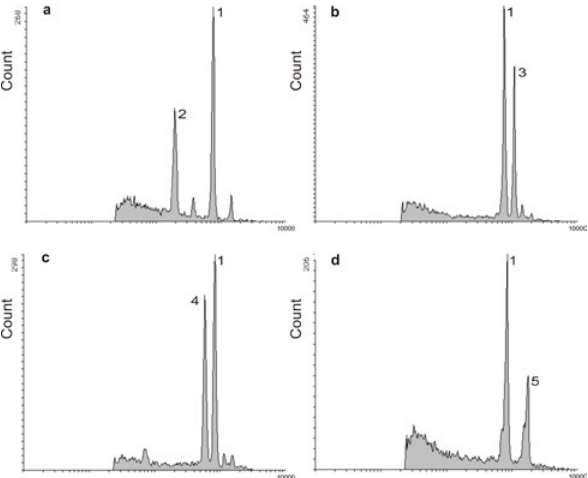
Fig. 4. Flow cytometry histograms (iodide propidium fluorescence intensity of nuclei) showing DNA amounts from leaf tissues of some Solanaceae species. 1 Pisum sativum “Ctirad” (standard). 2 S.